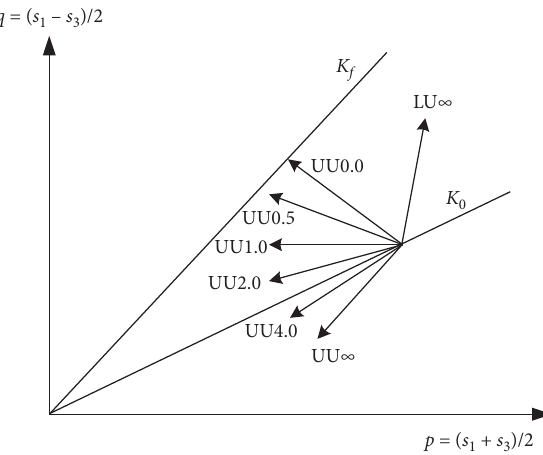
Figure 2: Stress paths and unloading